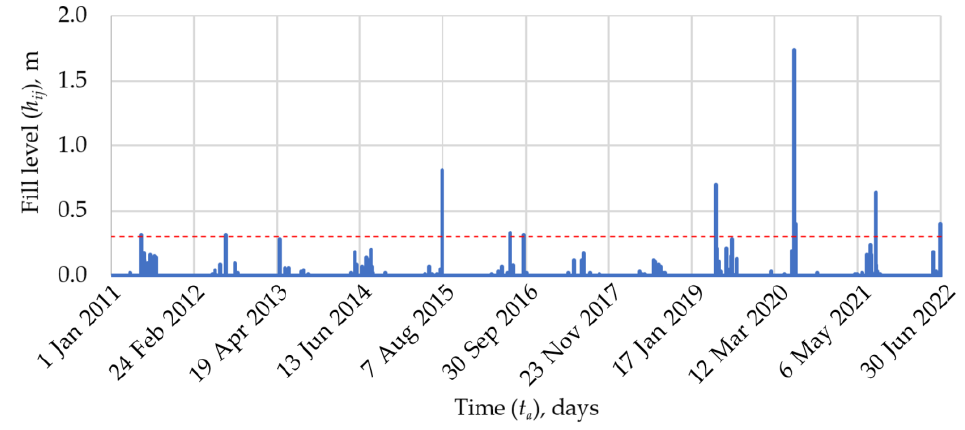
Figure 14. Stormwater fill level in the infiltration facility (blue line — actual fill level; red line — de- signed fill level).